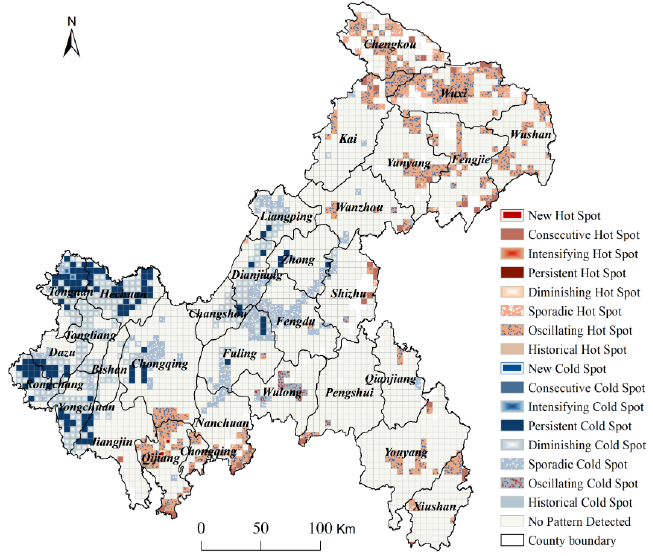
Figure 8. Cropland abandonment EHSA (emerging hot spot analysis) results for the period between 2001 and 2020.